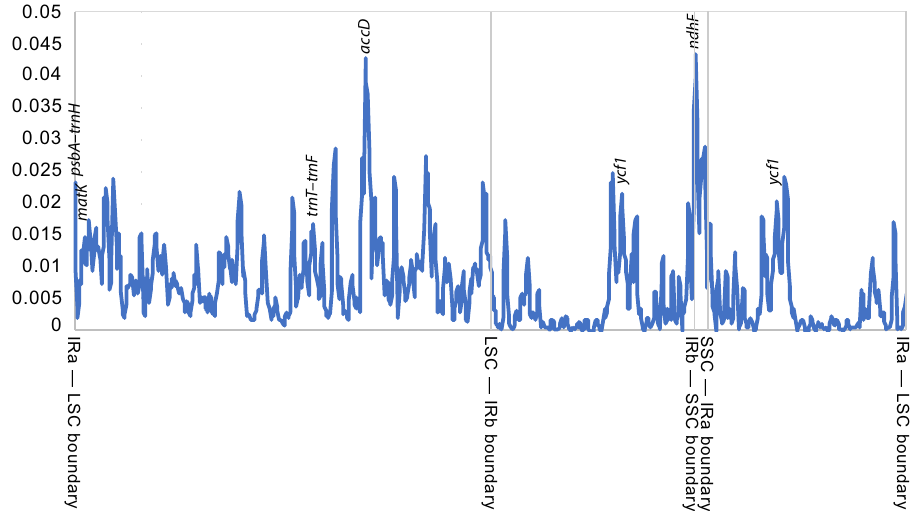
Figure 3. Nucleotide diversity (Pi) values of 20 complete ingroup plastomes, showing genome parts, barcoding regions commonly used in the taxa in question ( trnT-UGU – trnL-UAA – trnF-GAA , psbA–trnH , matK ) and genes in highly variable regions ( accD , ndhF and ycf1